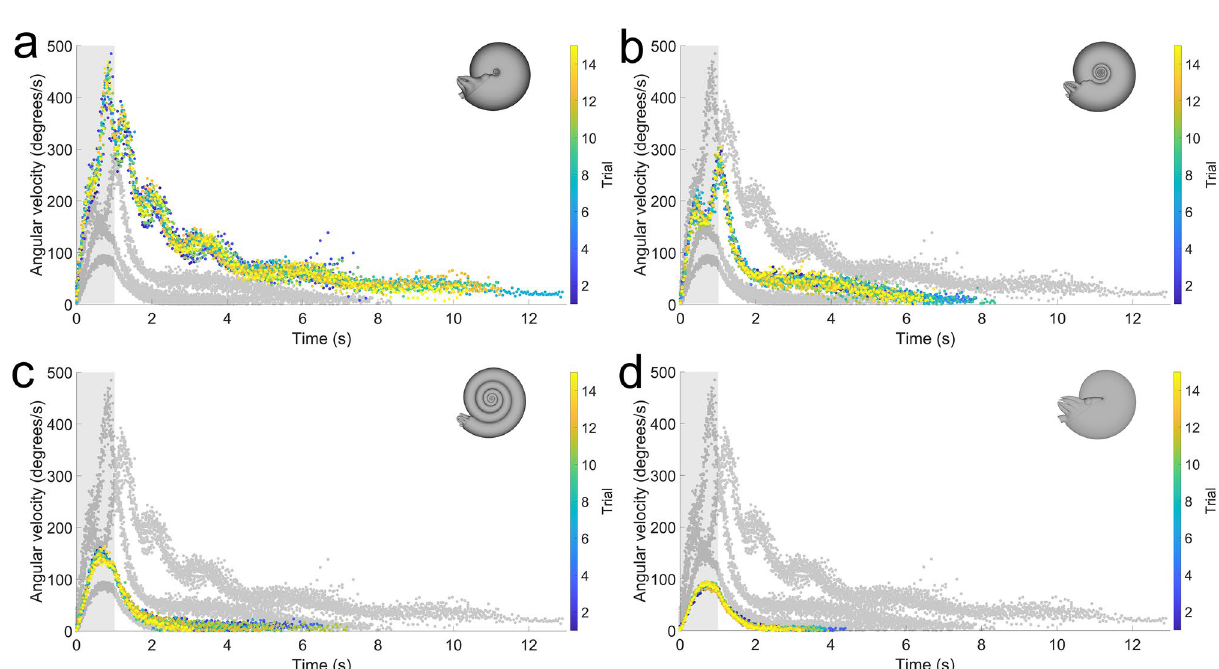
Figure 8. Angular velocity computed from rotation about the vertical axis (yaw). ( a ) Sphaerocone, ( b ) morphospace center, ( c ) serpenticone, and ( d ) oxycone. Shaded regions denote the time the motor was active (first second). Shaded curves denote the relative kinematics of each other robot. Colors indicate the trial performed for each robot (15